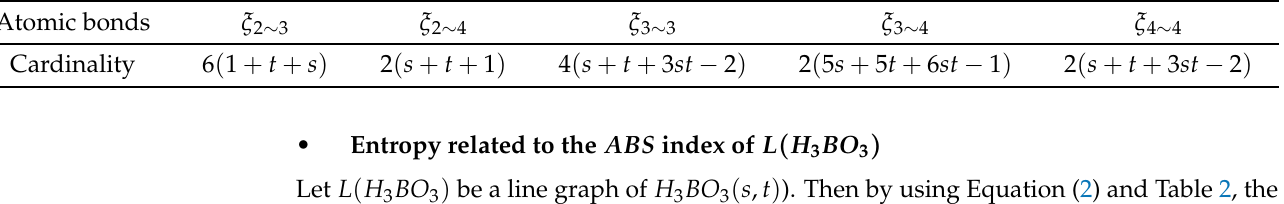
Table 2. Edge division based on vertices in the line graph H 3 BO 3 ( s , t ) layer structure. Atomic